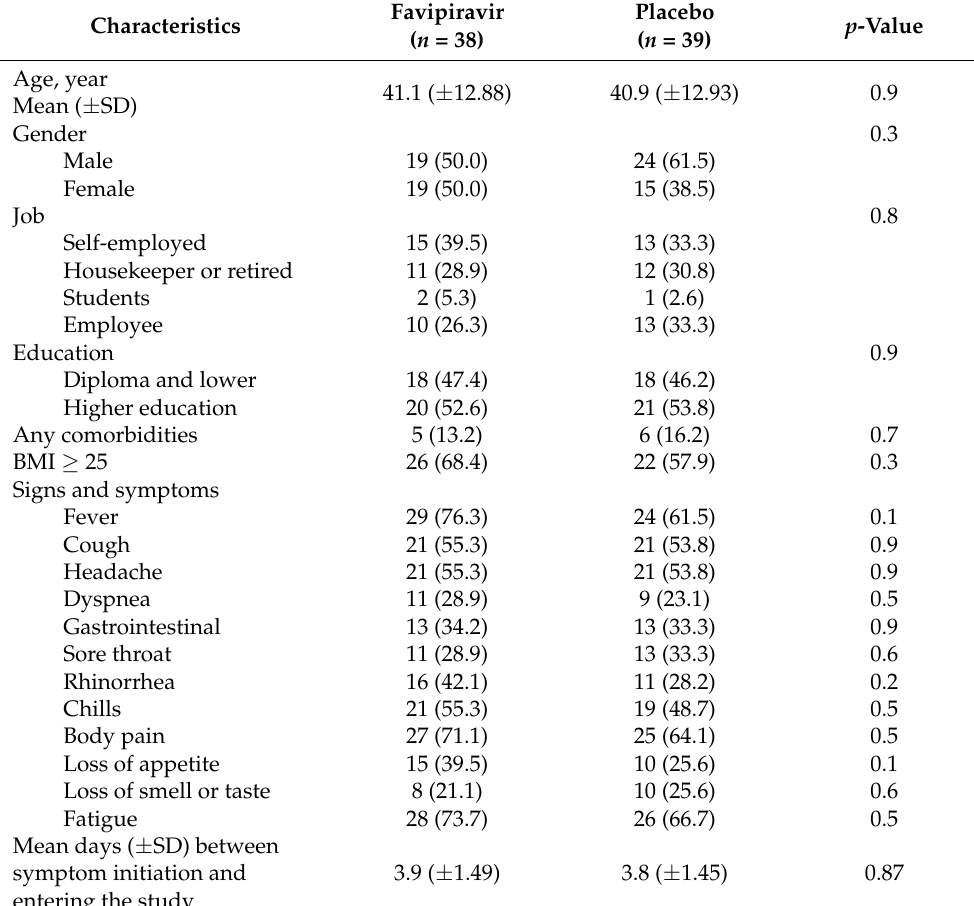
Table 1. Demographic and clinical characteristics of the patients by treatment groups.